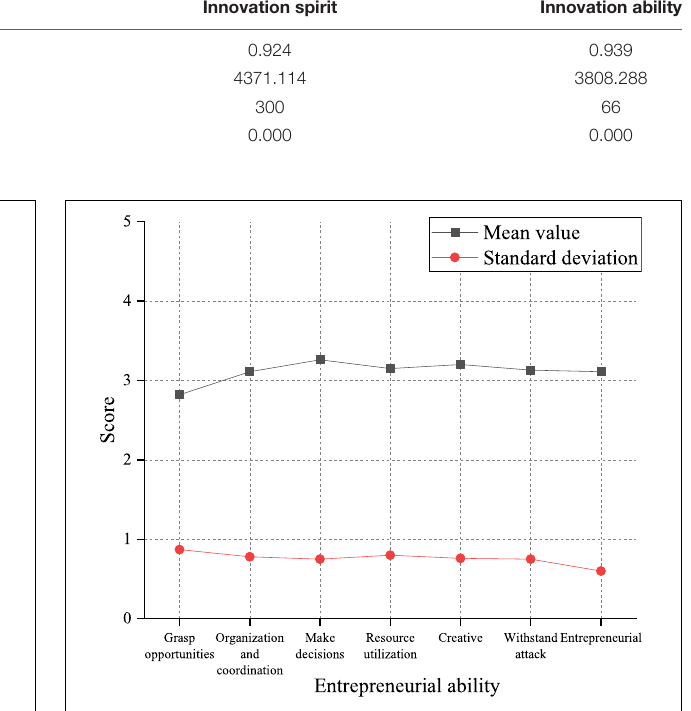
FIGURE 7 | Analysis of entrepreneurial competence of college